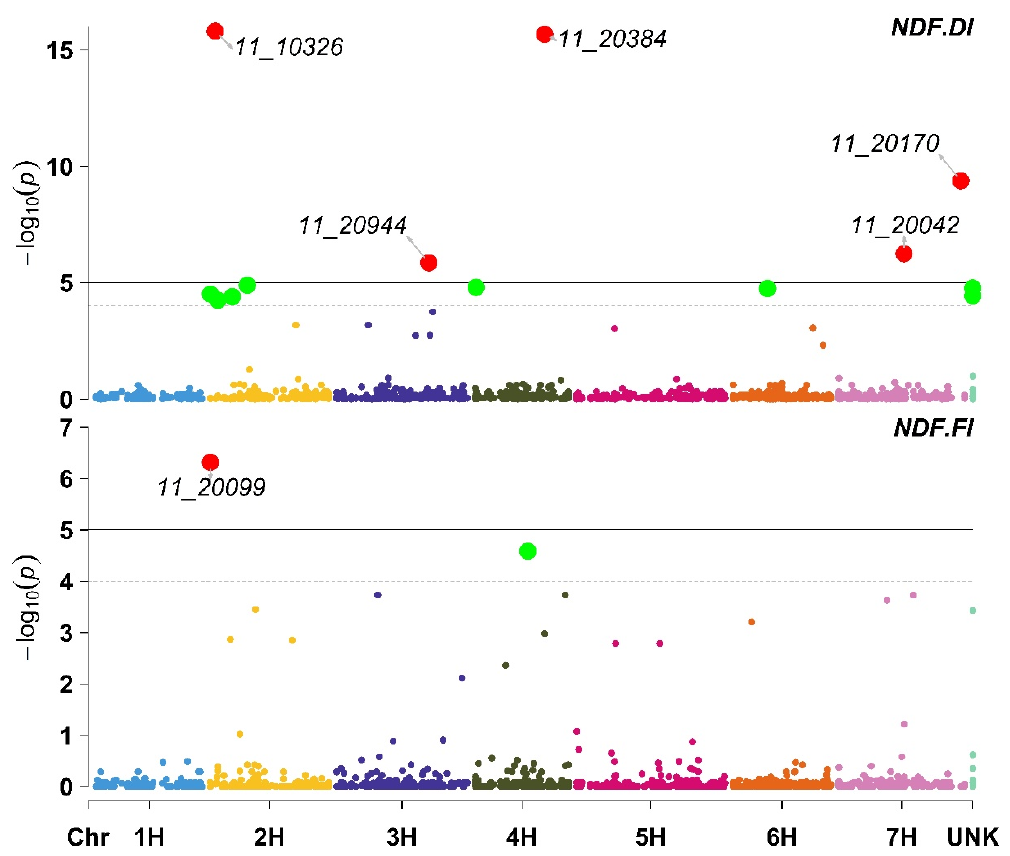
Figure 1. Manhattan plot displaying the results of the genome-wide association scan (red dots annotated dots refer to significant markers or markers with − log10 (p) more than 5, while the green dots refer to non-significant markers but have −log10 (p) between 4 and 5) for the number of days to flowering (NDF) using 426 barley lines under Deficit Irrigation (NDF.DI, upper plot) and Full Irrigation (NDF.FI, lower plot).